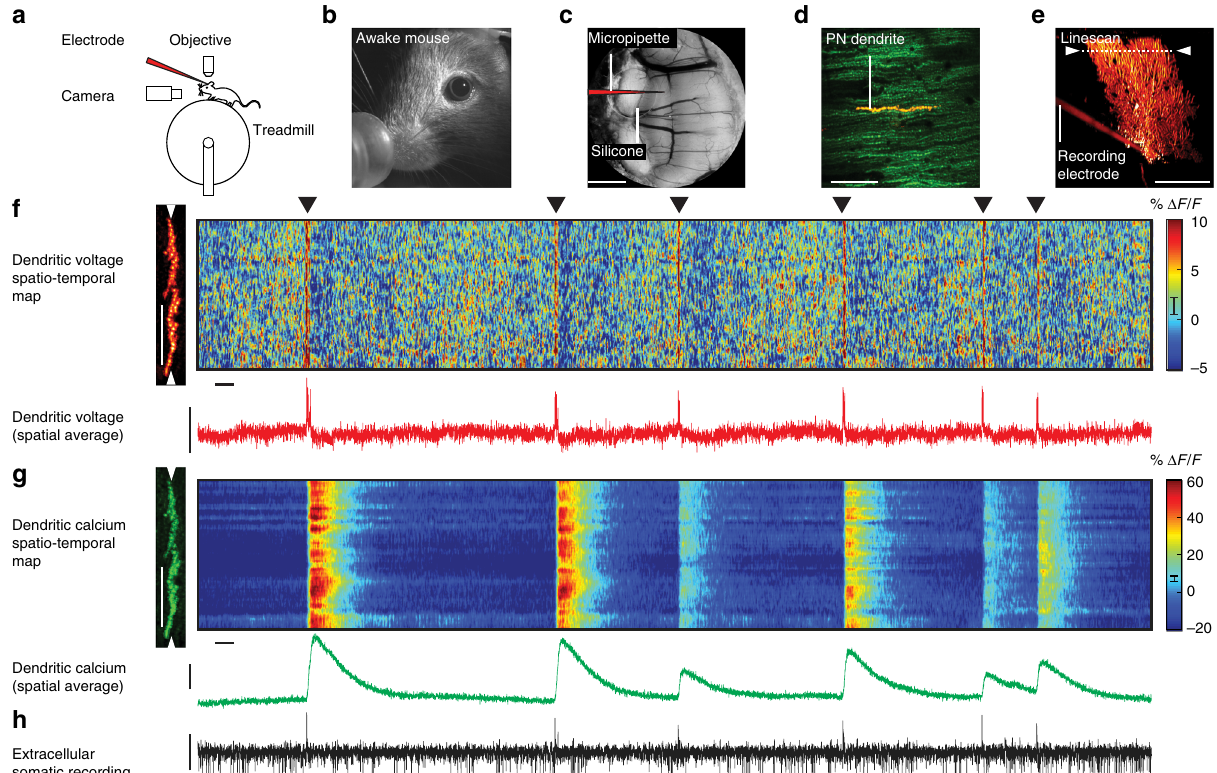
Fig. 1 Simultaneous dendritic voltage and calcium imaging and somatic recording from Purkinje neurons in awake mice. a Experiments were performed on head fi xed mice, alert and resting on a rotating treadmill. b A behaviour camera was used to monitor spontaneous movement in alert resting mice. c A cerebellar chronic cranial window with access port was used to label and record from single PNs in lobule V of the vermis. Scale bar 1 mm. d 2P image of distal PN spiny dendrites labelled with voltage sensitive dye ANNINE-6plus (red) and genetically encoded calcium indicator GCaMP6f (green), resulting in double labelling (yellow). Scale bar 100 μ m. e Reconstruction of a single labelled PN showing position of 2P linescan (white arrows) and extracellular electrode placed at the soma. Scale bar 100 μ m. f Spatiotemporal map obtained from 5 s of linescan recording (with 5 ms and 5 μ m boxcar fi ltering) show spontaneous dendritic voltage signals. Filled triangles indicate dendritic complex spikes (DCS). Subthreshold dendritic voltage modulation is also visible in the spatiotemporal voltage map. Vertical scale bar 50 μ m; horizontal scale bar 100 ms. Red trace shows spatially averaged voltage, recorded at 2 kHz resolution. Vertical scale bar 20% Δ F / F . g Corresponding spatiotemporal map for dendritic calcium. Vertical scale bar 50 μ m; horizontal scale bar 100 ms. Green trace shows spatially averaged calcium. Vertical scale bar 20% Δ F / F . h Corresponding extracellular recording (black trace) showing somatic CS and SS events (positive and negative going events respectively). Vertical scale bar 100 pA. Error bars in colour maps show estimates for shot